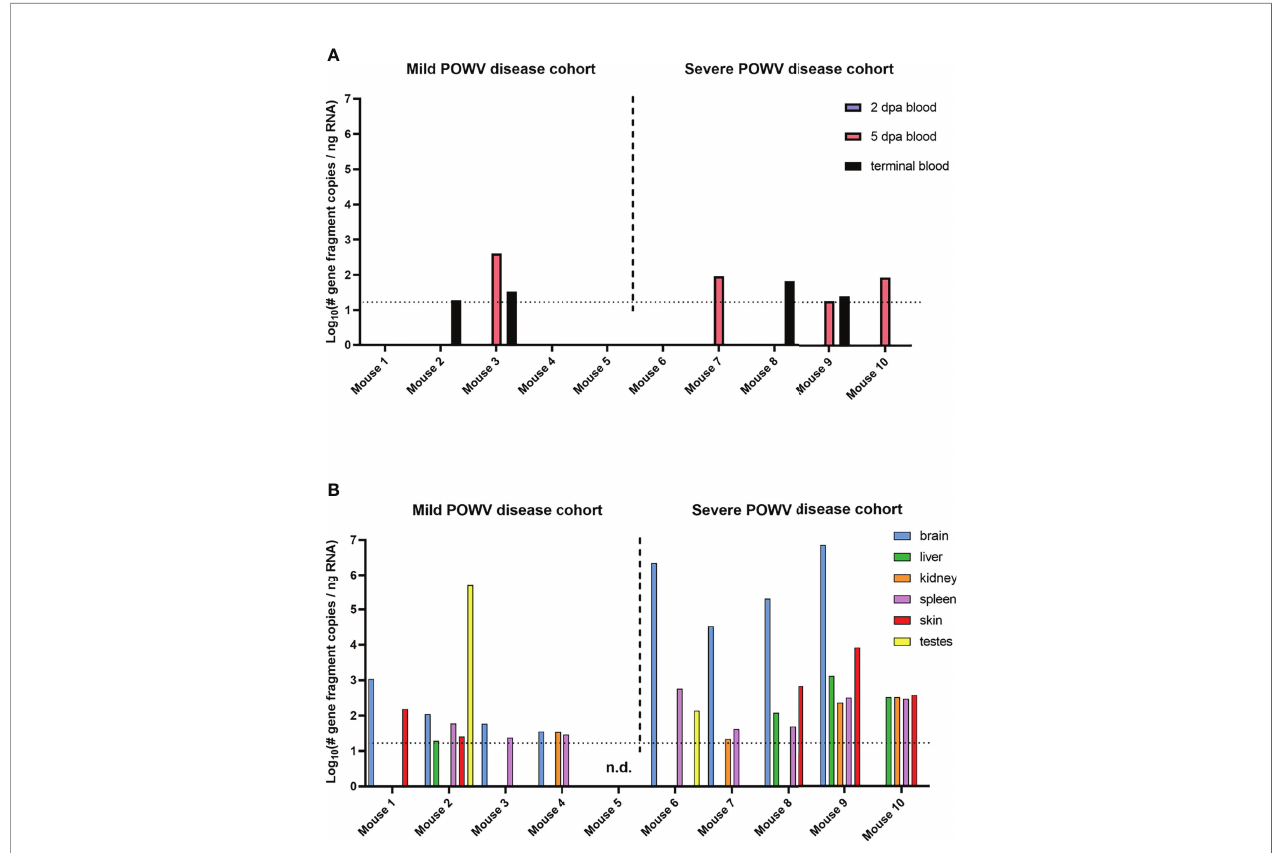
FIGURE 3 | Detection of POWV RNA in blood (A) and tissues (B) collected from mice infested with POWV-infected H. longicornis . Mice 1 - 9 were each infested with an individual POWV II-injected adult female tick. Mouse 10 was infested with larvae (derived from the adult female tick fed on Mouse 6). Data are shown for mice with mild disease that survived to the study endpoint of 28 days post-attachment (d.p.a.) and those with severe disease that quali fi ed for euthanasia before 28 d.p.a. Blood samples were taken at 2 d.p.a., 5 d.p.a., and at the time of necropsy. POWV RNA was detected in samples via q-RT-PCR. Viral RNA quantities are expressed as the number of NS5 gene fragment copies per ng of RNA after normalization to a standard curve. Each bar represents a single data point from a single tissue. Limit of detection ~15 gene fragment copies per ng RNA. n.d., not